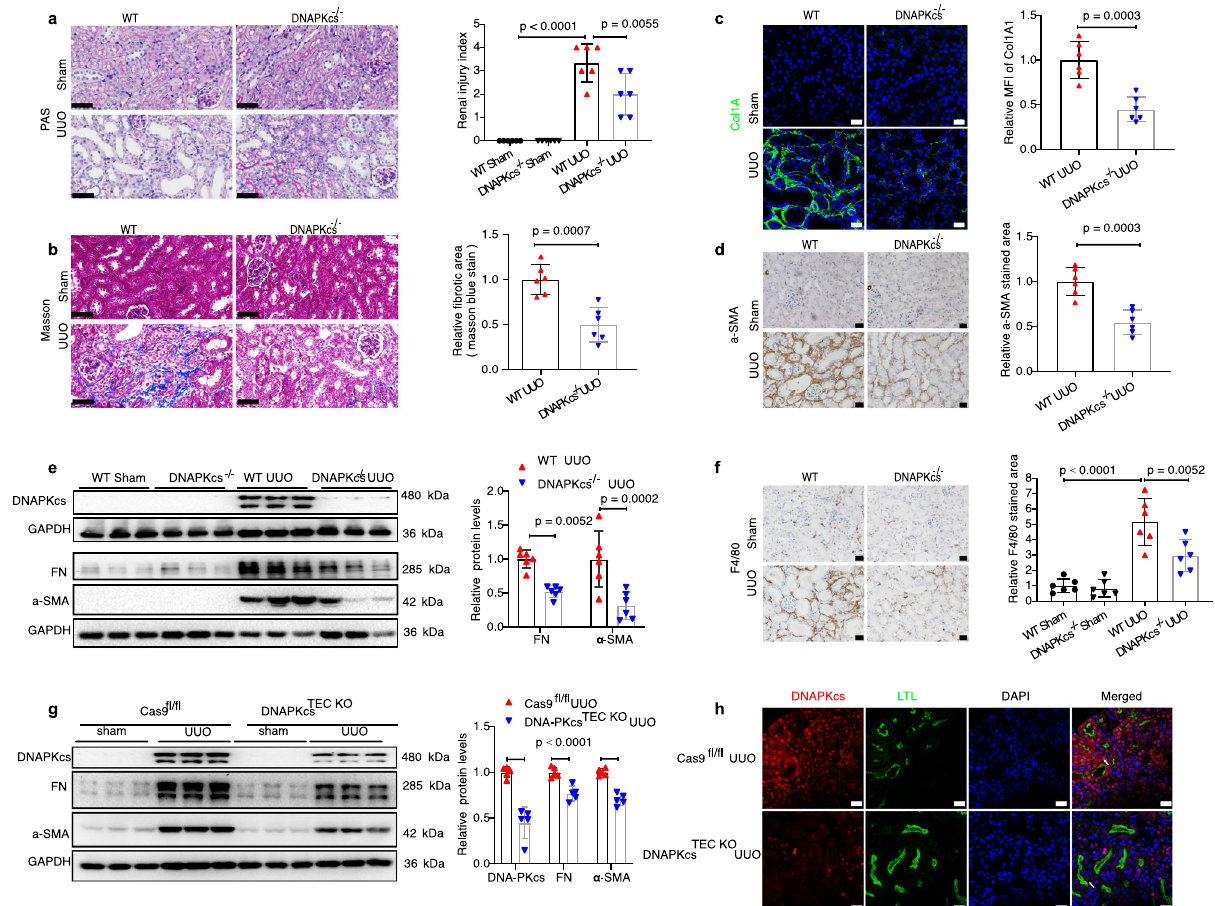
Fig. 2 | Deletion of DNA-PKcs attenuates the progression of CKD in UUO mice. a PAS staining of kidneys of WT and DNA-PKcs − / − mice subjected to UUO (day 7), scale bars: 50 μ m. Bars represent quanti fi cation results (mean±SD, n =6 mice of eachgroup). b MassonstainingofkidneysofWTandDNA-PKcs − / − micesubjectedto UUO (day 7), scale bars: 50 μ m. c Immuno fl uorescence staining of COL1A1, scale bars:20 μ m,MFImean fl uorescenceintensity.Barsrepresentquanti fi cationresults (mean±SD, n =6 mice of each group). d Immunohistochemical staining of α -SMA in kidneys of WT and DNA-PKcs − / − mice subjected to UUO (bar: 20 μ m). Bars represent quanti fi cation results (mean±SD, n =6 mice of each group). e Protein levelsofDNA-PKcs,FNand α -SMAinkidneysofWTandDNA-PKcs − / − micesubjected toUUO.Barsrepresentquanti fi cationresults(mean±SD, n =6miceofeachgroup). f Immunohistochemical staining of F4/80 in kidneys of WT and DNA-PKcs − / − mice